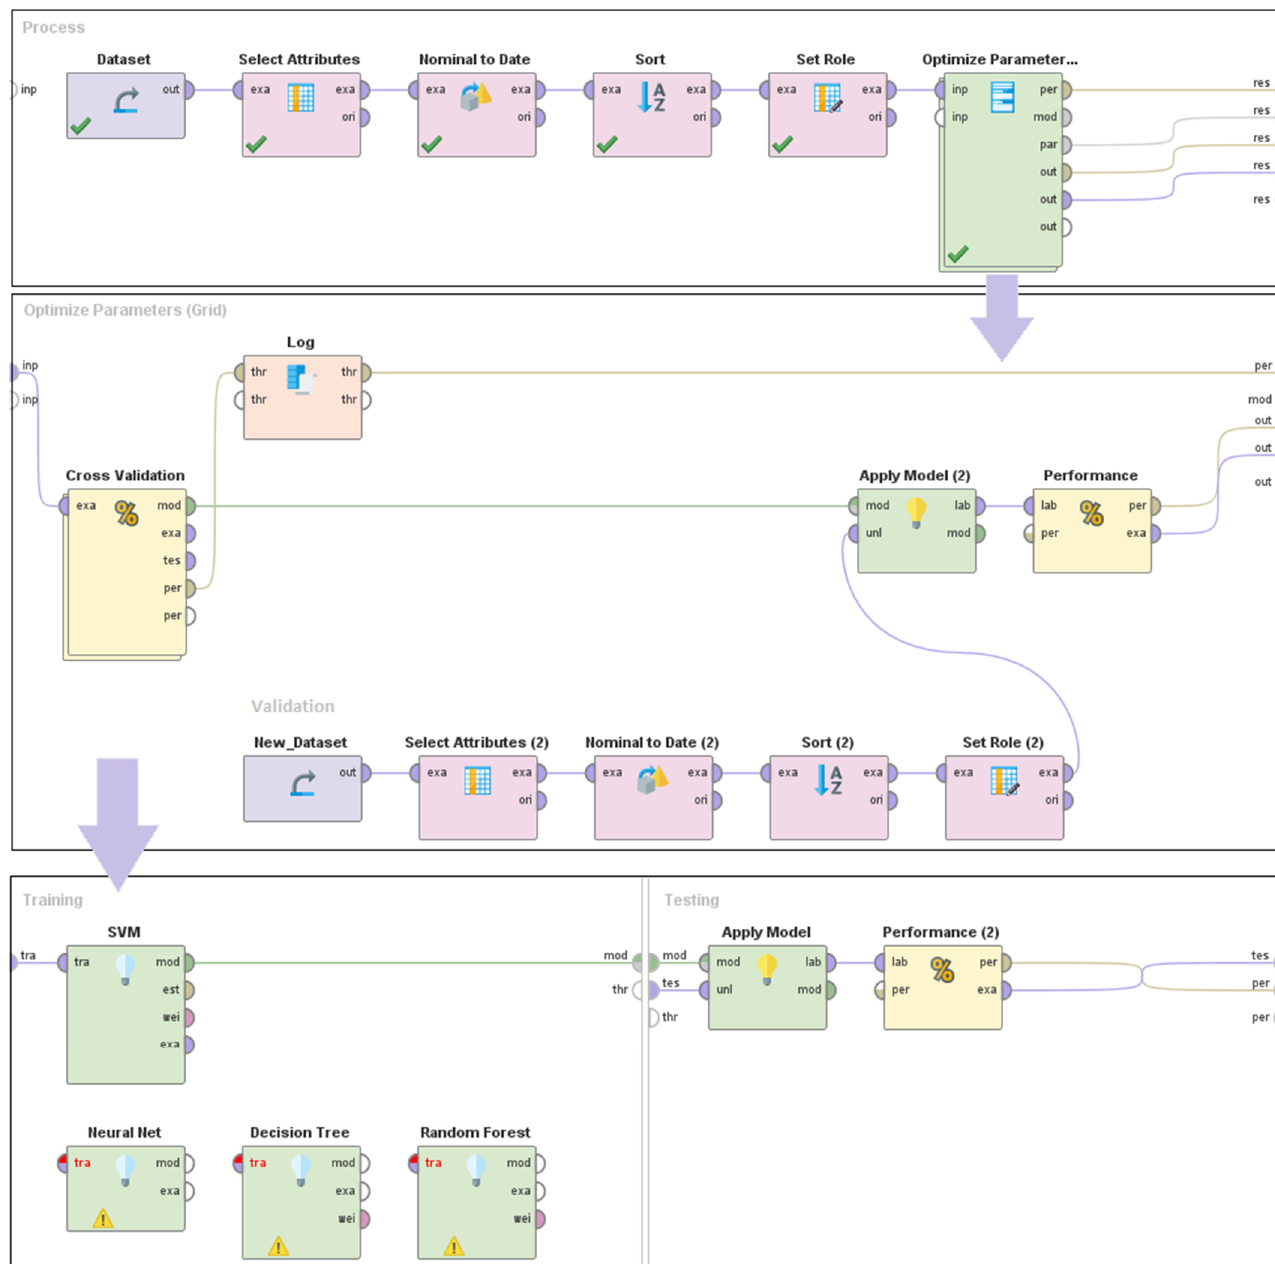
Figure 7. Stream of the process in RapidMiner Studio .